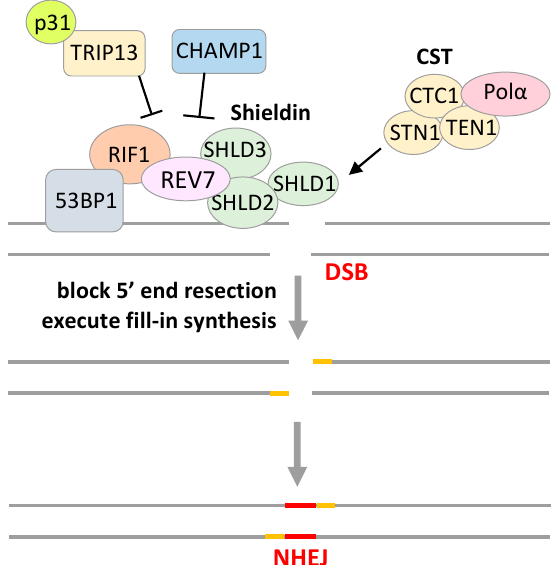
Figure 3. Involvement of REV7 in double-strand break (DSB) repair. At a DSB lesion, 53BP1–RIF1 recruits the Shieldin complex (SHLD1, SHLD2, SHLD3, and REV7) to block 5’ end resection, and Shieldin also recruits the CST complex (CTC1, STN1, and TEN1) together with DNA polymerase α (Pol α ) to execute fill-in synthesis, resulting in the inhibition of HR and the facilitation of non-homologous end joining (NHEJ). CHAMP1 binds to REV7 promoting the decreased level of the Shieldin complex, and p31 comet –TRIP13 binds to REV7 in the Shieldin complex and promotes its dissociation from SHLD3 by inducing O-REV7 from C-REV7, resulting in a reduction in the Shieldin complex activity.